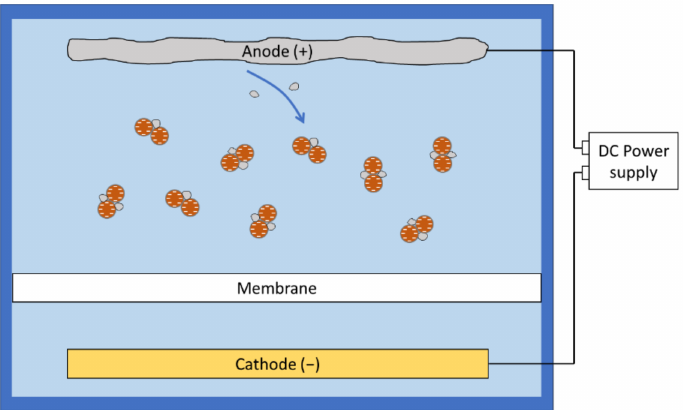
Figure 5. Electrocoagulation under a direct current